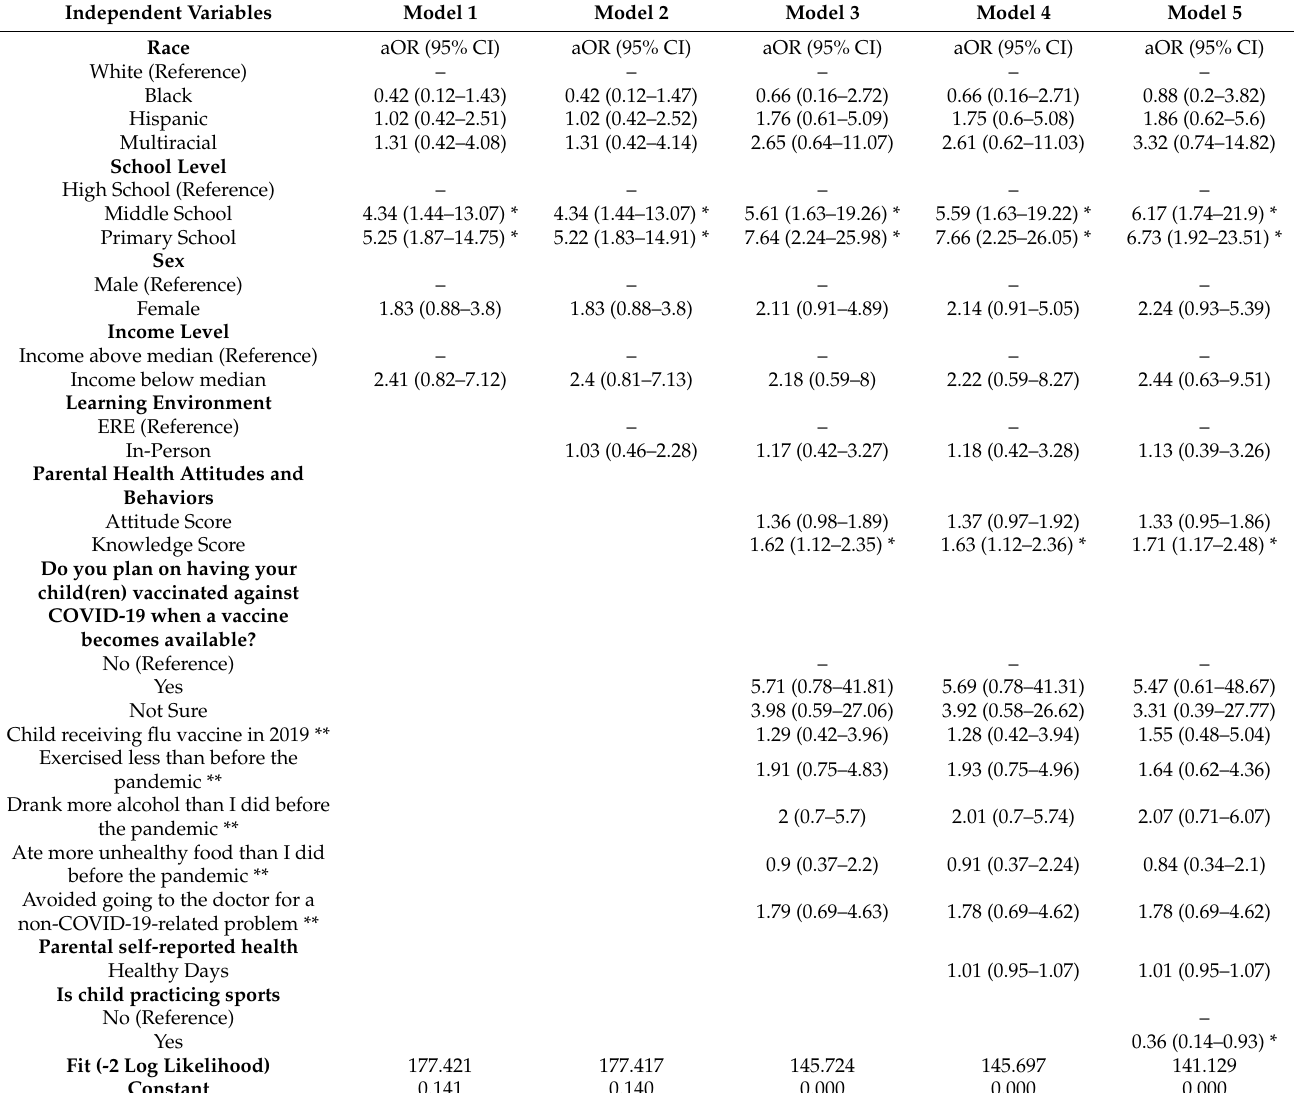
Table 2. Nested Logistic Regression Models Examining the Effects of Sociodemographic Characteristics, Learning En- vironment, Parental Health Attitudes and Behaviors, and other Selected Factors on Students Presenting as At Risk for